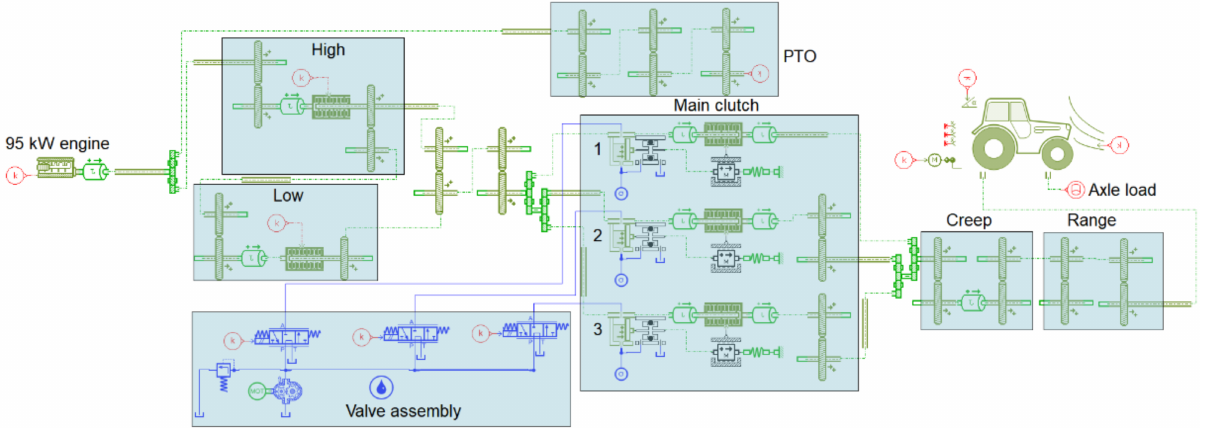
Figure 2. The simulation model of the entire PST tractor used in this